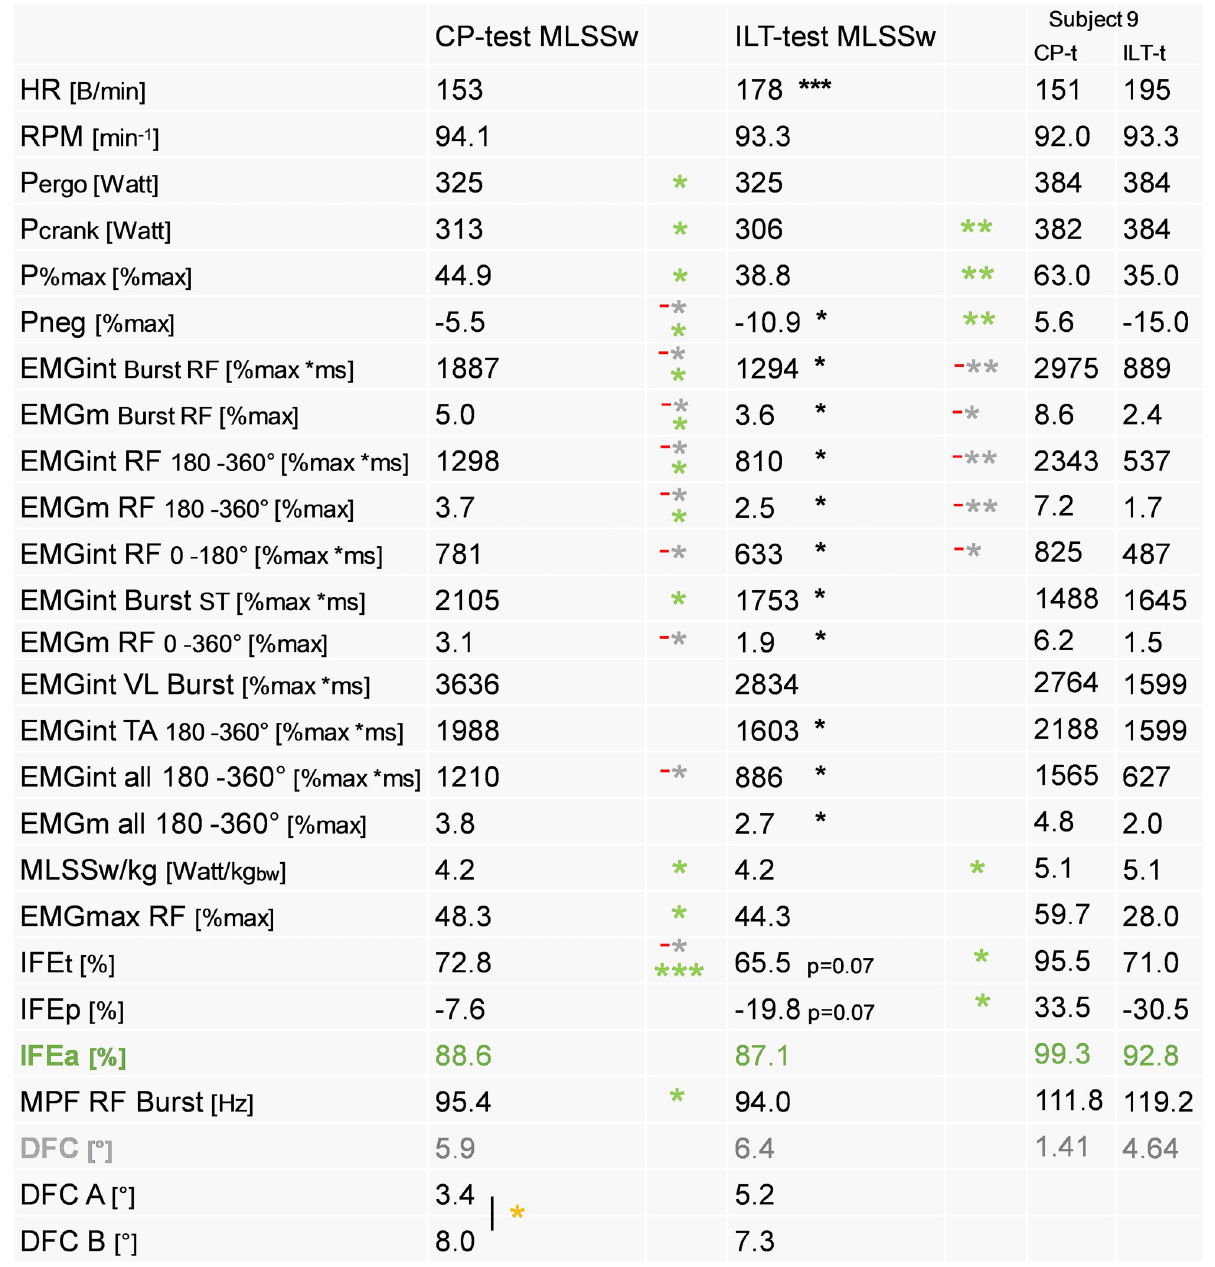
Fig 9. Comparison of parameters relevant for coordination and effective force development in CP- and ILT-tests. Time-based results for ILT- vs CP-tests reveal differences for RF and partially for ST, and TA activity as well as for the average EMG of all 4 recorded muscles (EMGm all) in the second part of the pedal cycle for all examined subjects (n = 11) and for subject 9. The delay of force crossings (DFCs) is inversely correlated to activation behavior of the RF which parallels results from CP-tests (see also Fig 7). Note that the correlation between IFEa and RF-activity between 180˚-360˚ is missing in the ILT-test. P%max and Pneg are shown as mean of both cranks. IFE(t,a,p) is shown as mean of the right crank. For detailed description of data analysis and parameter definitions see Methods and S1 Fig. Grey asterisks ( � ): correlation to DFC, green asterisks ( � ): correlation to IFEa, black asterisks ( � ): two-tailed paired t-tests, yellow asterisks ( � ): two-tailed unpaired t-tests. Shown is mean. � P < 0.05, �� P < 0.01, ��� P < 0.001.